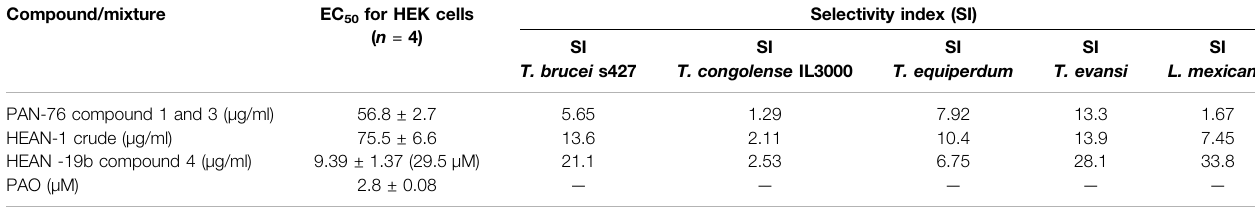
TABLE 4 | Toxicity of mixtures and compound 4 to HEK cells.